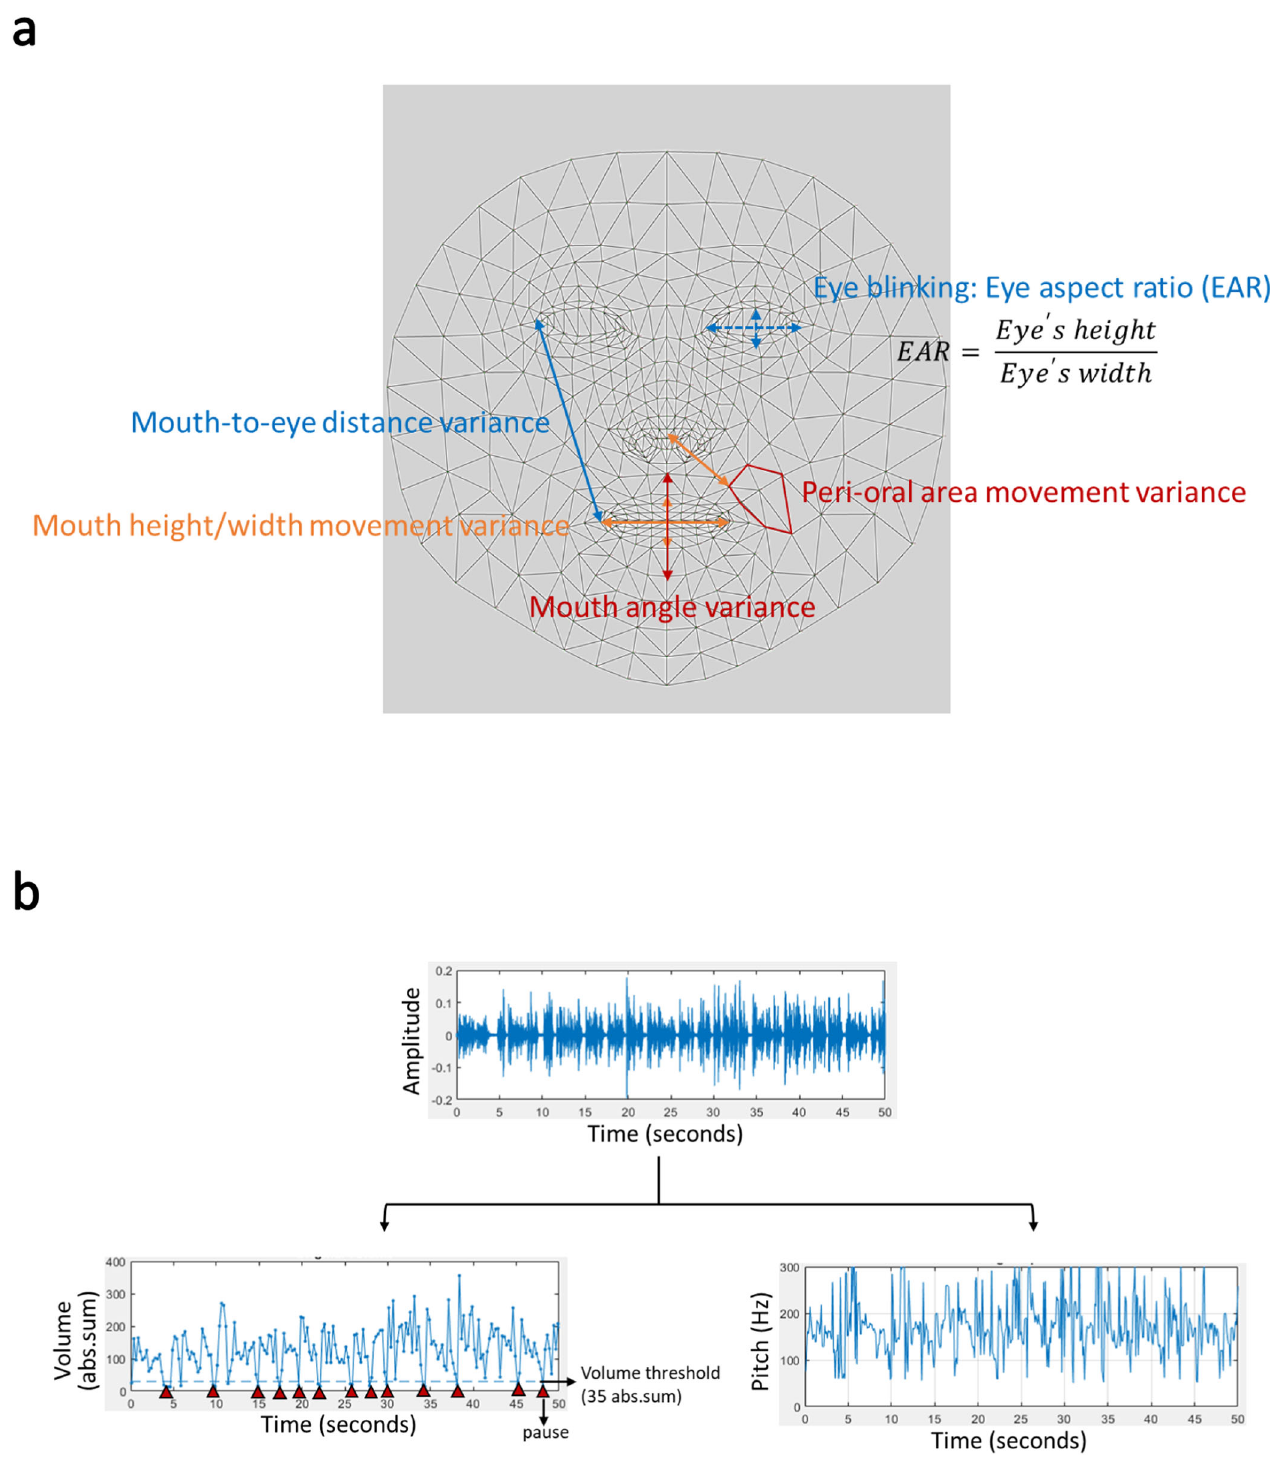
Fig. 4 Voice and facial expression features analyzed in this study. a The diagram illustrates the facial features extracted from facial landmarks with Google Media Pipe Face Mesh. These features were: eye blinking (EAR), mouth to eye distance variance, mouth height and width movement variances, peri-oral area movement variance, and mouth angle variance. b The voice recording is divided into volume and pitch eye distance variances; and the peri-oral area movement variances. These features are de fi ned below.